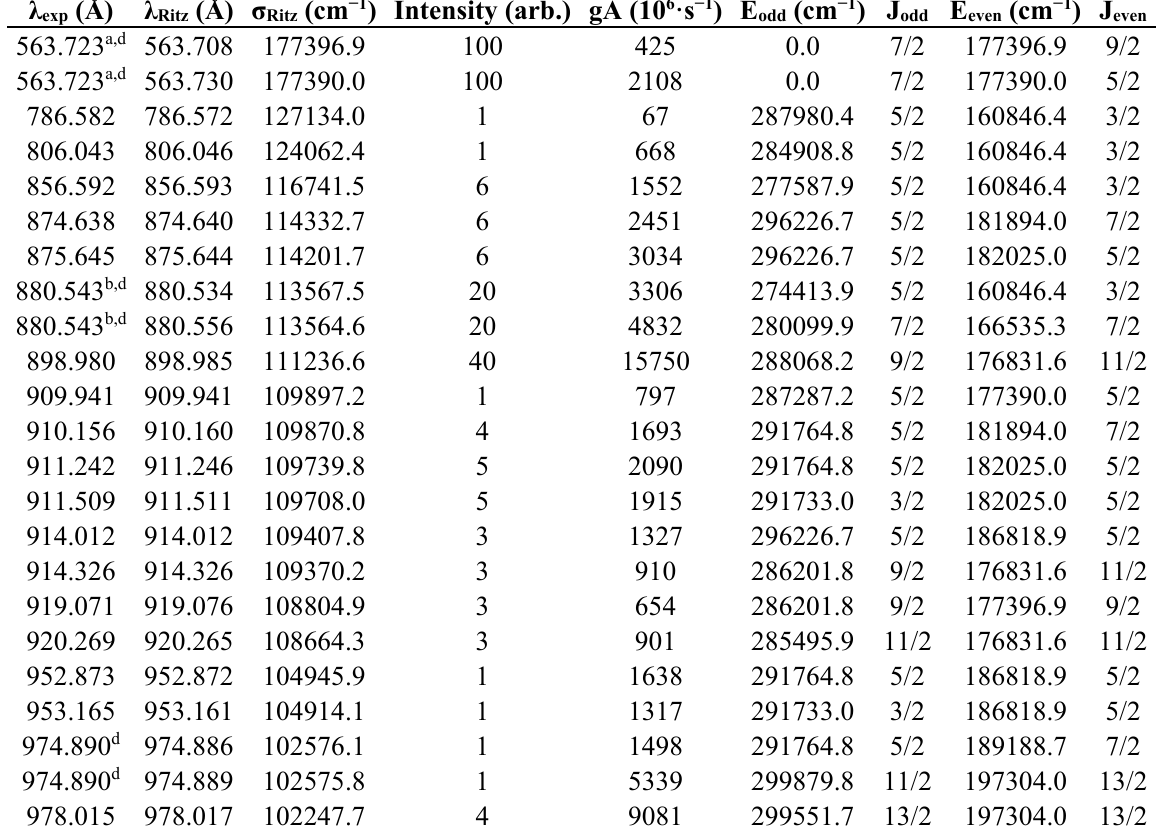
Table 2. Newly identified lines of Lu V. Experimental wavelengths (estimated uncertainty ±0.005 Å) and intensities (in arbitrary units) are taken from the line list of [21]. Calculated gA values are from the present